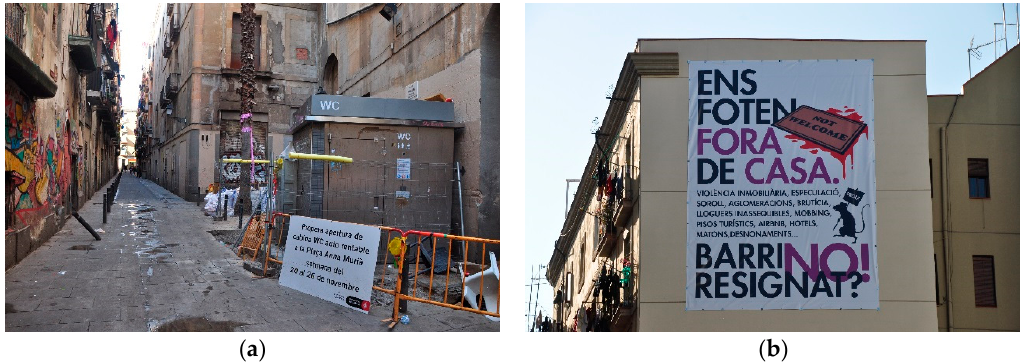
Figure 6. El Raval: ( a ) rubbish and deterioration, and ( b ) neighborhood demands.